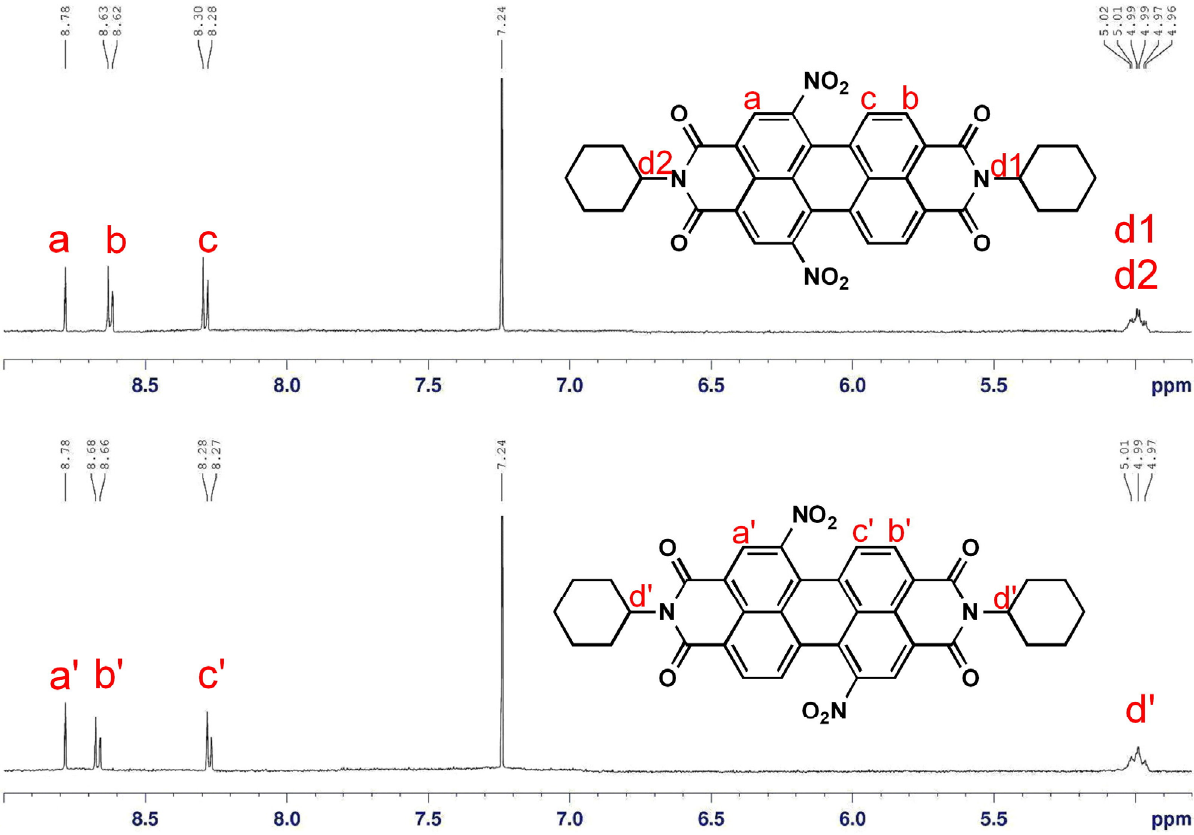
Figure 1. 1 H-NMR (500 MHz, CDCl bisimides 1,6- A (top) and 1,7- A